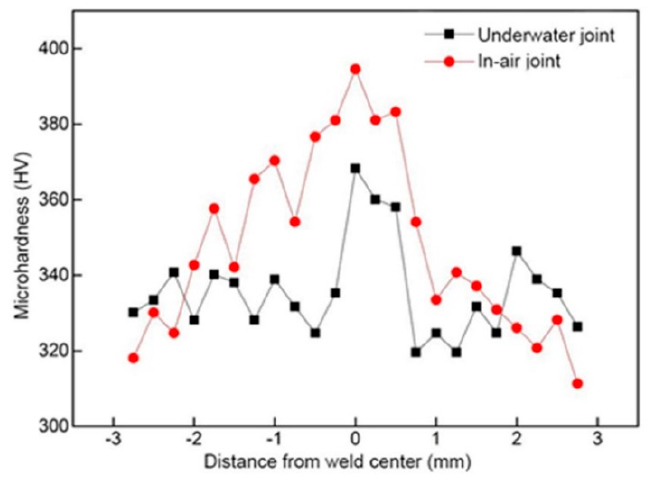
Figure 18. The impact toughness of the underwater and in-air welded joints.